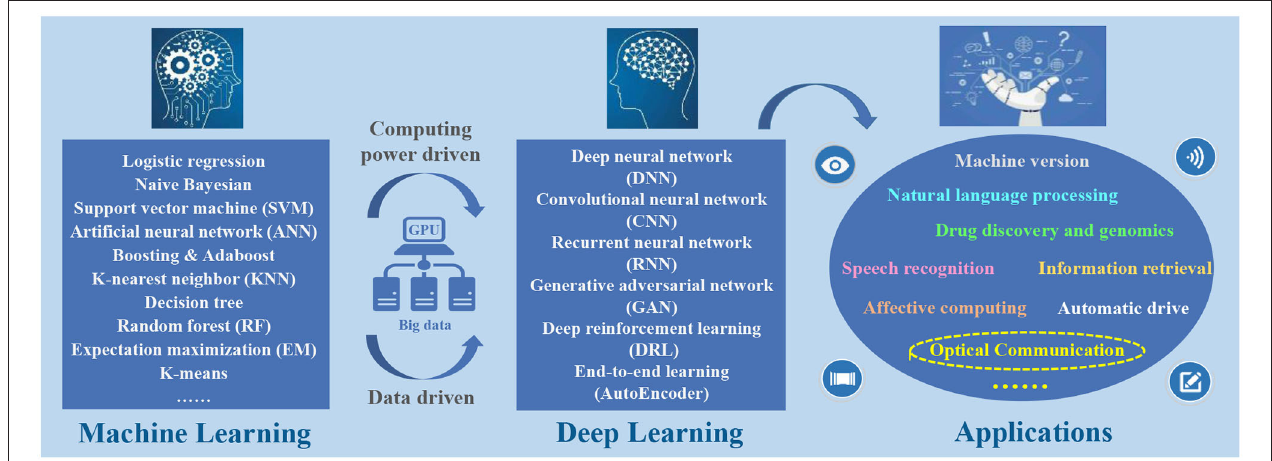
FIGURE 1 | Advances in artificial intelligence in optical communications. Driven by powerful parallel computing capacity and big data, traditional machine learning algorithms are progressing to deep learning techniques with a variety of applications, promoting the evolution of optical communications toward